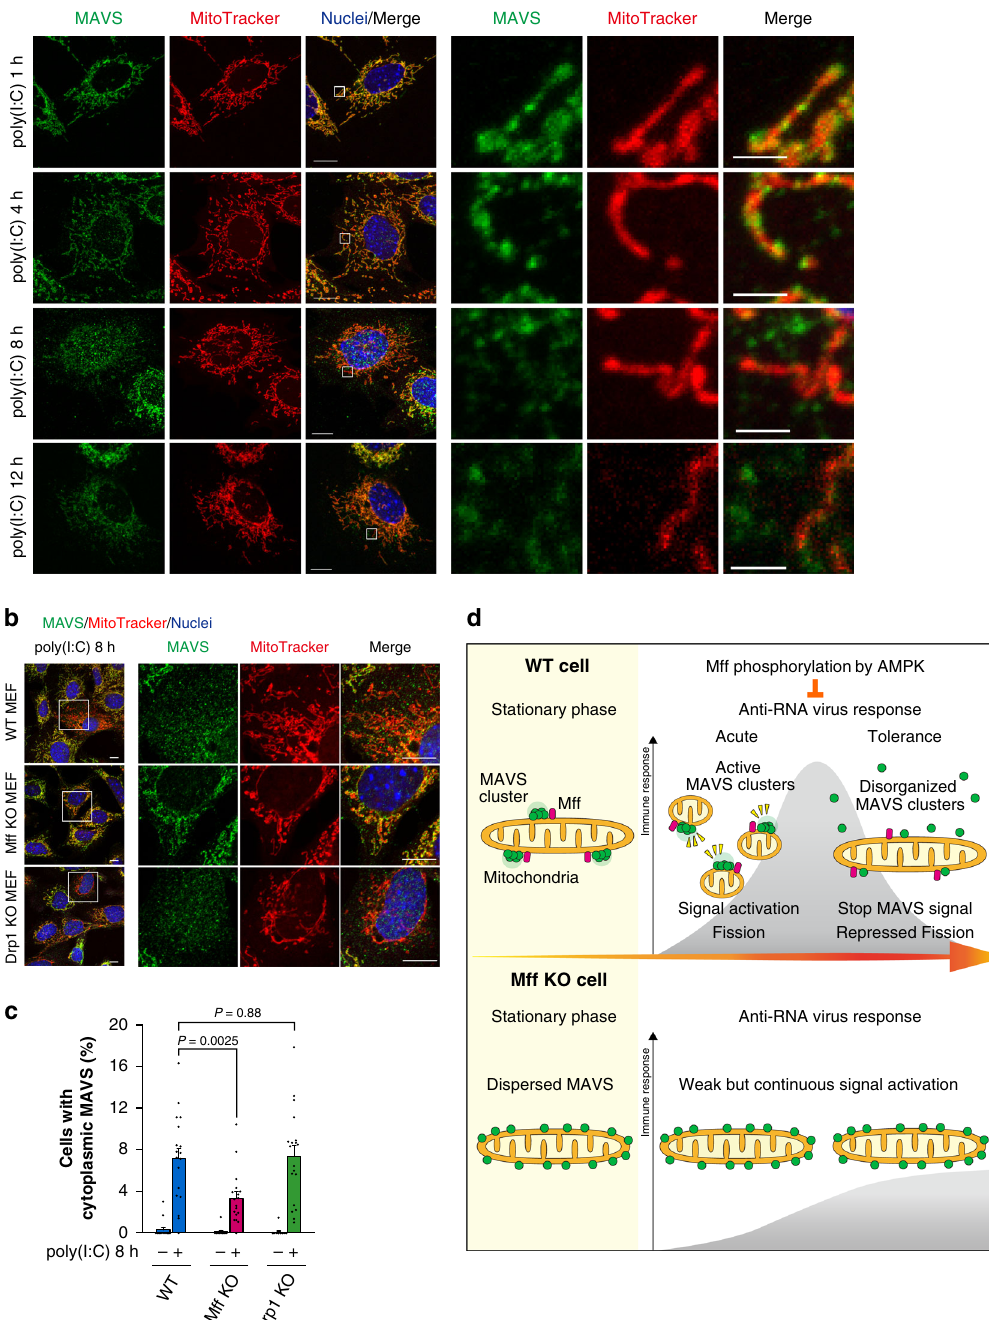
Fig. 7 Clearance of mitochondrial MAVS clusters by Mff. a Confocal microscopic images of MAVS and mitochondria. WT MEFs were transfected with poly(I:C)-LMW (1 μ g/mL) for the indicated times. Cells were stained with MitoTracker Red (mitochondria; red) and immunostained with an anti-MAVS antibody (green). Nuclei were stained with Hoechst 33342 (blue). A magni fi ed view of the boxed region is shown in the right panel. Scale bars: 10 μ m (whole) and 2 μ m (magni fi ed). b WT, Mff KO, and Drp1 KO MEFs were stained with MitoTracker Red (mitochondria; red) and immunostained with an anti- MAVS antibody (green) with poly(I:C)-LMW (1 μ g/mL) transfection for 8 h. Nuclei were stained with DAPI (blue). A magni fi ed view of the boxed region is shown in the right panel. Scale bars: 10 μ m. c The percentage of cells with cytoplasmic MAVS (MAVS signal without MitoTracker Red) was calculated. Data represent means ± SEM of three independent experiments (WT, Mff KO, Drp1 KO; n = 18, 18, 19, P values; two-tailed unpaired t test). d Working hypothesis for the mitochondrial membrane subdomains with MAVS clusters in antiviral innate immunity, dynamically regulated by the mitochondrial fi ssion factor Mff and AMPK. All microscopic analyses were repeated independently more than three times with similar results. Source data are provided as a Source data fi